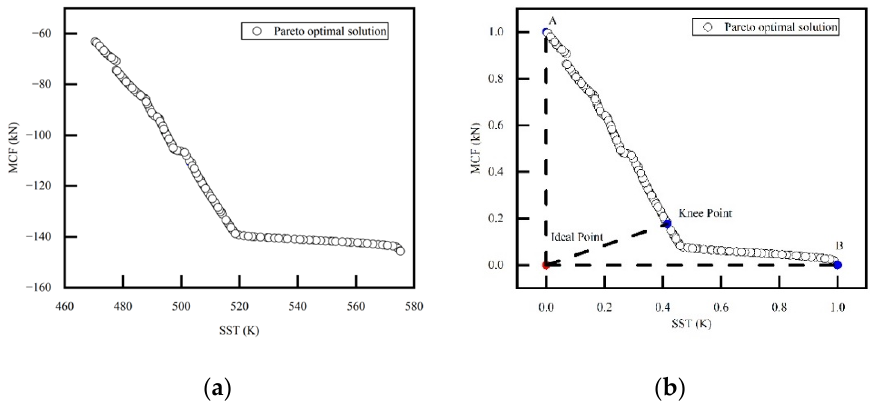
Figure 14. Pareto front of the multi-object optimization problem. ( a ) Original Pareto front; ( b ) nor- malized Pareto front.